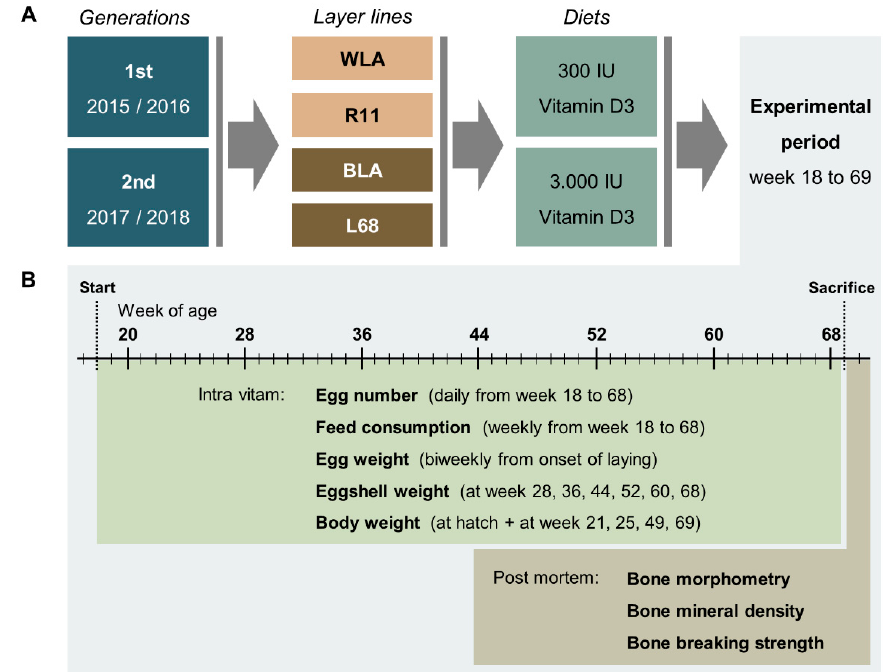
Figure 1. Schematic illustration of the experimental setup ( A ) and related data collection ( B ). In two consecutive generations, four chicken layer lines were allocated to a diet containing either 300 or 3000 IU of vitamin D3. During the experimental period, data on egg number, egg quality, feed consumption and body weight were collected as indicated. Post mortem , bone morphometry, bone mineral density and bone breaking strength were assessed.